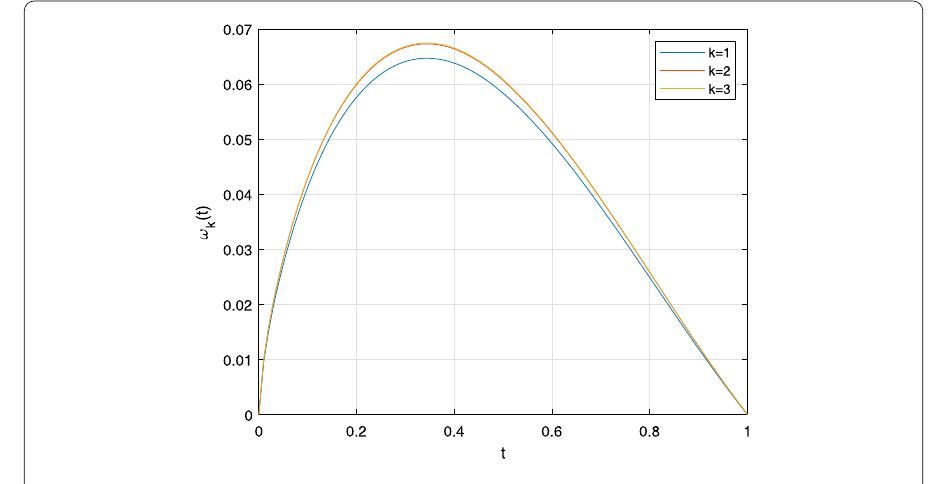
Figure 2 Graphs of the successive approximation of